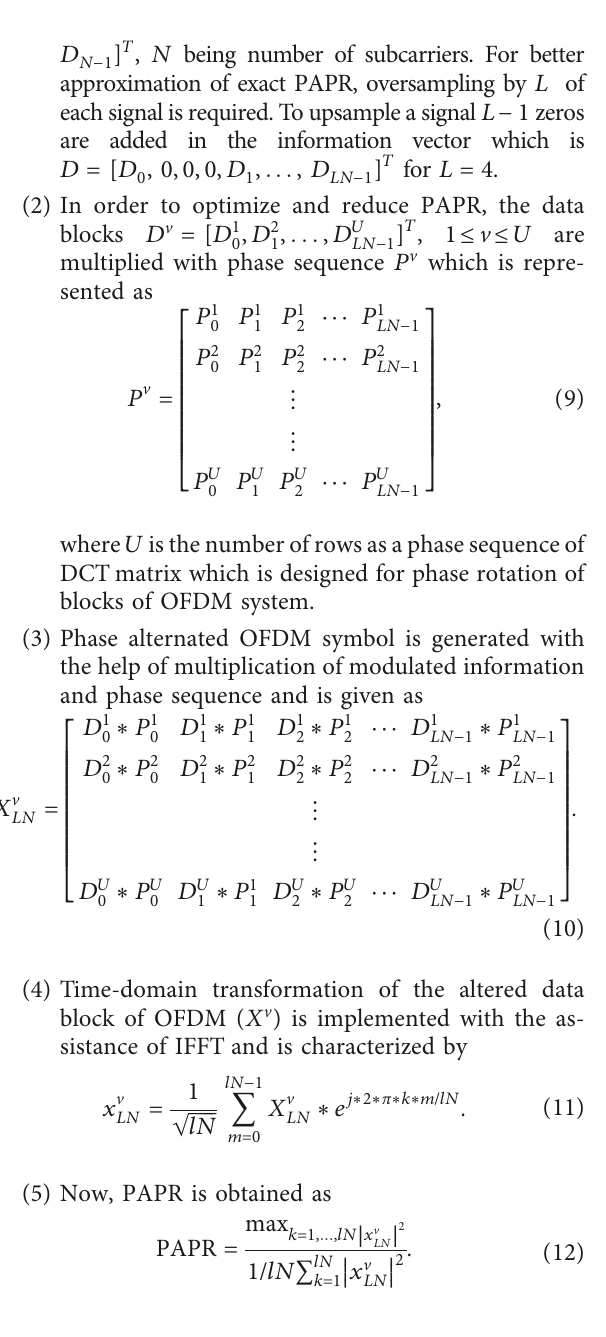
Figure 1: Proposed SLM technique using DCT for OFDM